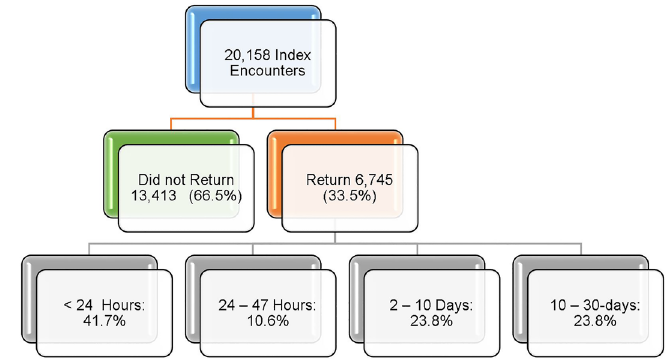
Figure 1. Descriptive characteristics of patients who left before treatment was completed.